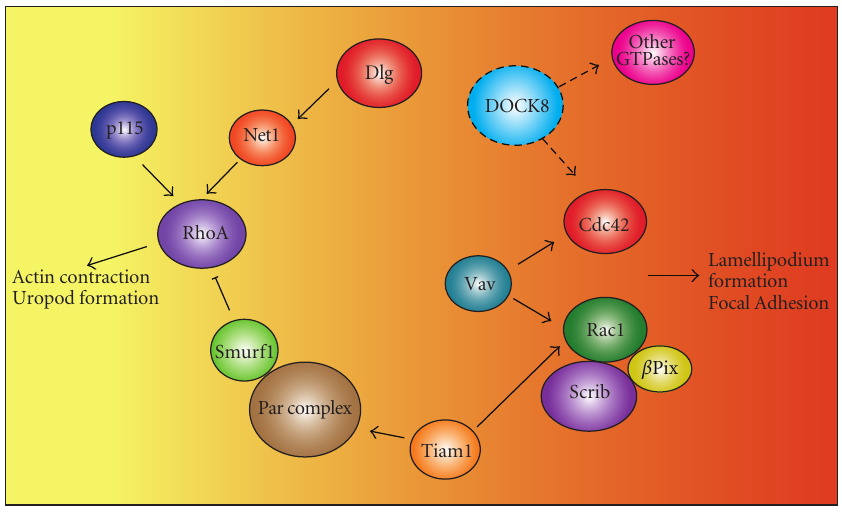
Figure 2: GEFs and polarity proteins are important GTPase regulators. GTPases function as switches in cells, controlling a large variety of pathways. They are tightly regulated by Guanine exchange factors (GEFS), GTPase activating proteins (GAPS) and polarity proteins. The recently discovered that GEF, DOCK8, may also be part of this large network. Evidence has shown that it interacts with Cdc42, an important GTPase in the regulation of cell morphology and motility. DOCK8 may also be a regulator of other GTPases that control di ff erent cellular functions important for T-cell